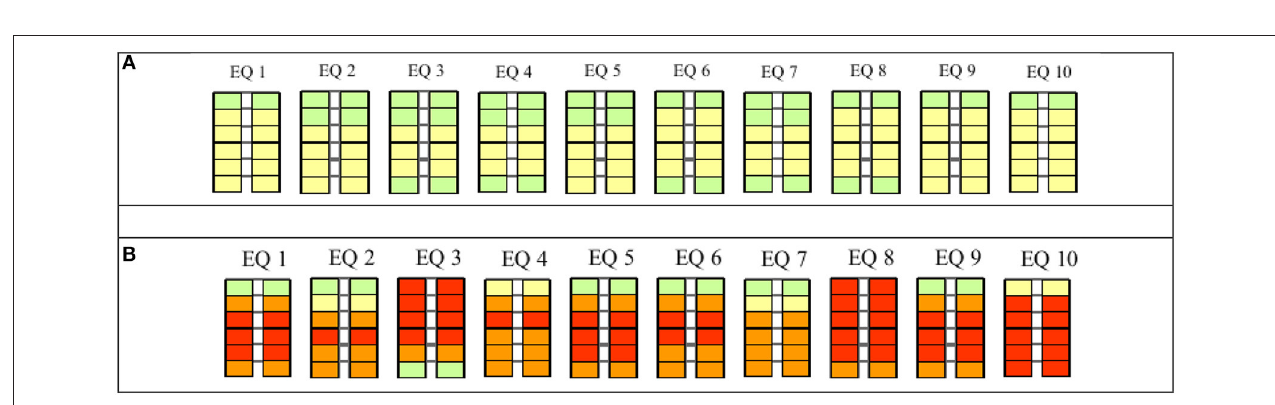
FIGURE 26 | Damage distribution of infilled frame designed for peak ground acceleration (PGA) = 0.35 g · S and subjected to the input ground motions scaled to damage limit state (DLS): PGA = 0.35 g · S · 0.5. (A) Innovative infills and (B) “traditional-T2” infills.